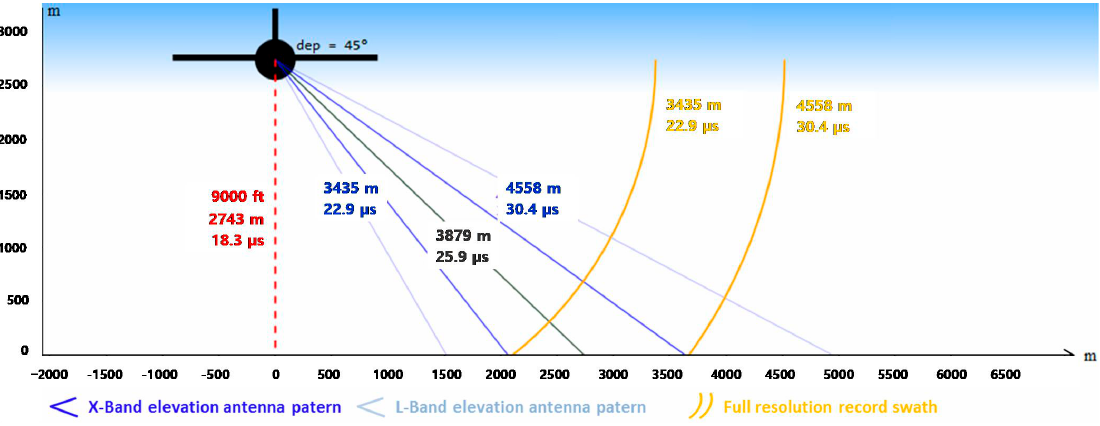
Figure 6. Radar acquisition geometry operated during the NOFO oil-on-water exercise.